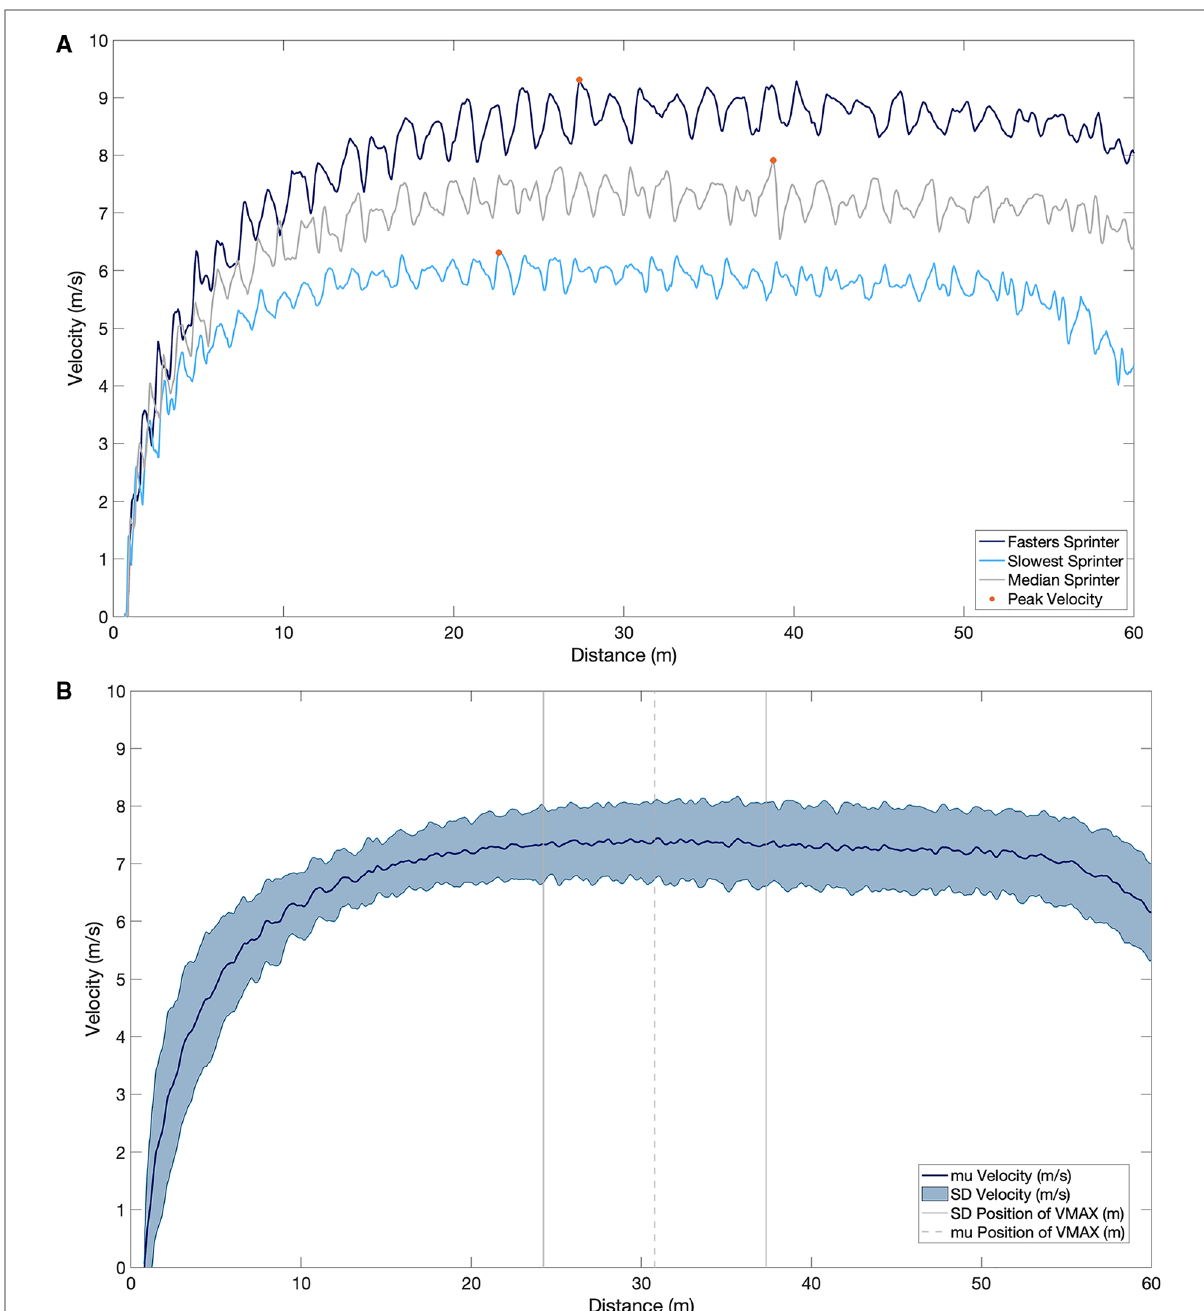
FIGURE 4 ( A ) the velocity pro fi le of the fastest sprinter (dark blue), slowest sprinter (light blue) and median sprinter (grey) for the entire 60 m. Peak velocity is represented by the orange dot on each velocity pro fi le. ( B ) The mean and standard deviation velocity pro fi le over the 60 m sprint and the mean and standard deviation of the position of the maximal